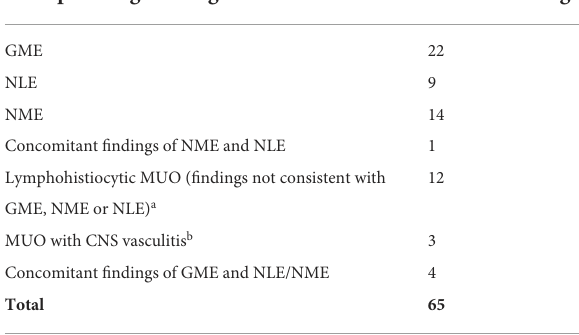
TABLE 1 All cases of dogs with meningoencephalitis of unknown origin (MUO) examined in both pathological institutes from 2010 to